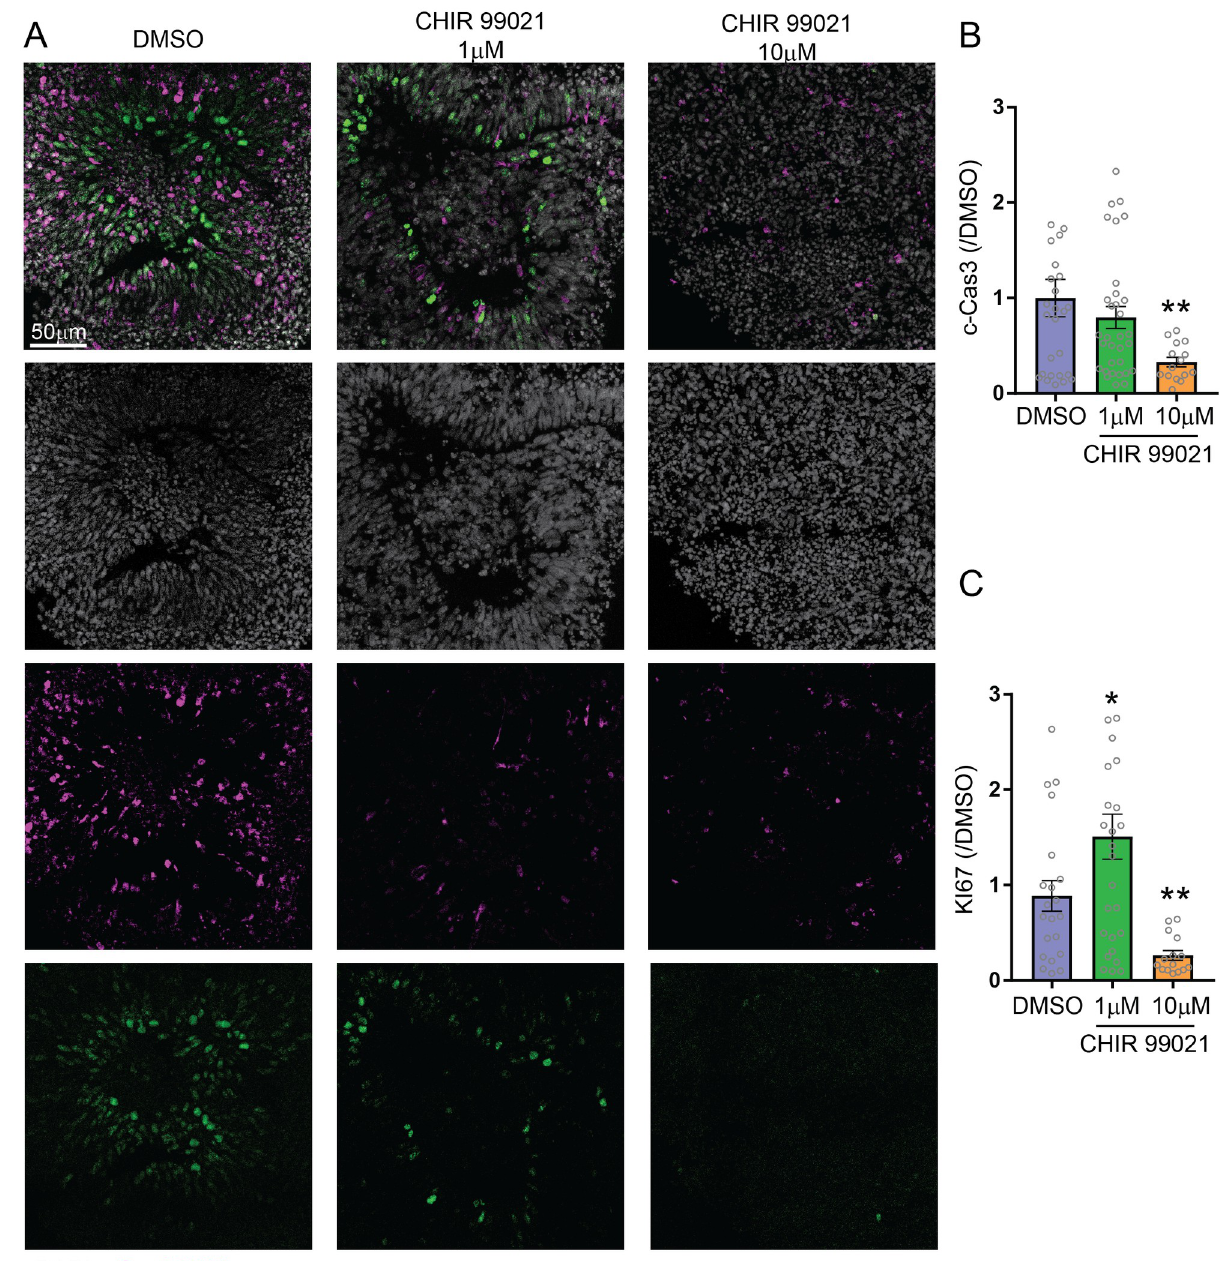
Fig 2. GSK3 β inhibition by CHIR 99021 decreases apoptosis, and at high dose, but not low dose, decreases proliferation. A . Representative images of immunostained organoids. The apoptosis marker cleaved caspase 3 (c-Cas3) and proliferation marker KI67 were immunolabeled. B . Quantification of the c-Cas3 or KI67 positive areas normalized by the DAPI positive area for each organoid (c-Cas3: DMSO: 1 ± 0.1972, n = 27; 1 μ M: 0.7968 ± 0.1147, n = 32; 10 μ M: 0.3282 ± 0.04979, n = 15; DMSO vs 1 μ M, p-value = 0.3592, DMSO vs 10 μ M, � : p-value = 0.0185. KI67: DMSO: 0.8857 ± 0.1606, n = 21; 1 μ M: 1.508 ± 0.2367, n = 27; 10 μ M: 0.2625 ± 0.05119, n = 15; DMSO vs 1 μ M, � : p-value = 0.0463, t-test; DMSO vs μ M, �� : p-value = 0.0031; unpaired t- test). Bar graphs represent mean ± SEM.